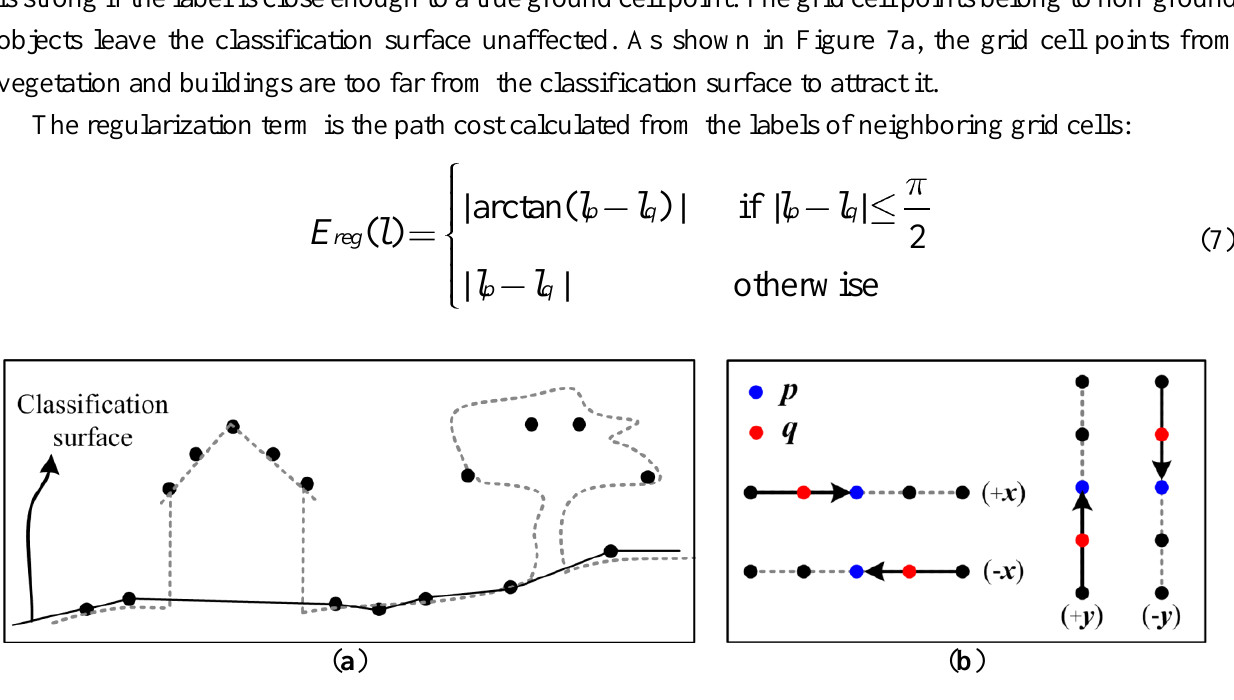
Figure 7. ( a ) Cross-section of a scene: the classification surface is attracted to the ground while the tree and building points are too far to attract the classification surface; ( b ) q is the grid cell before p along a